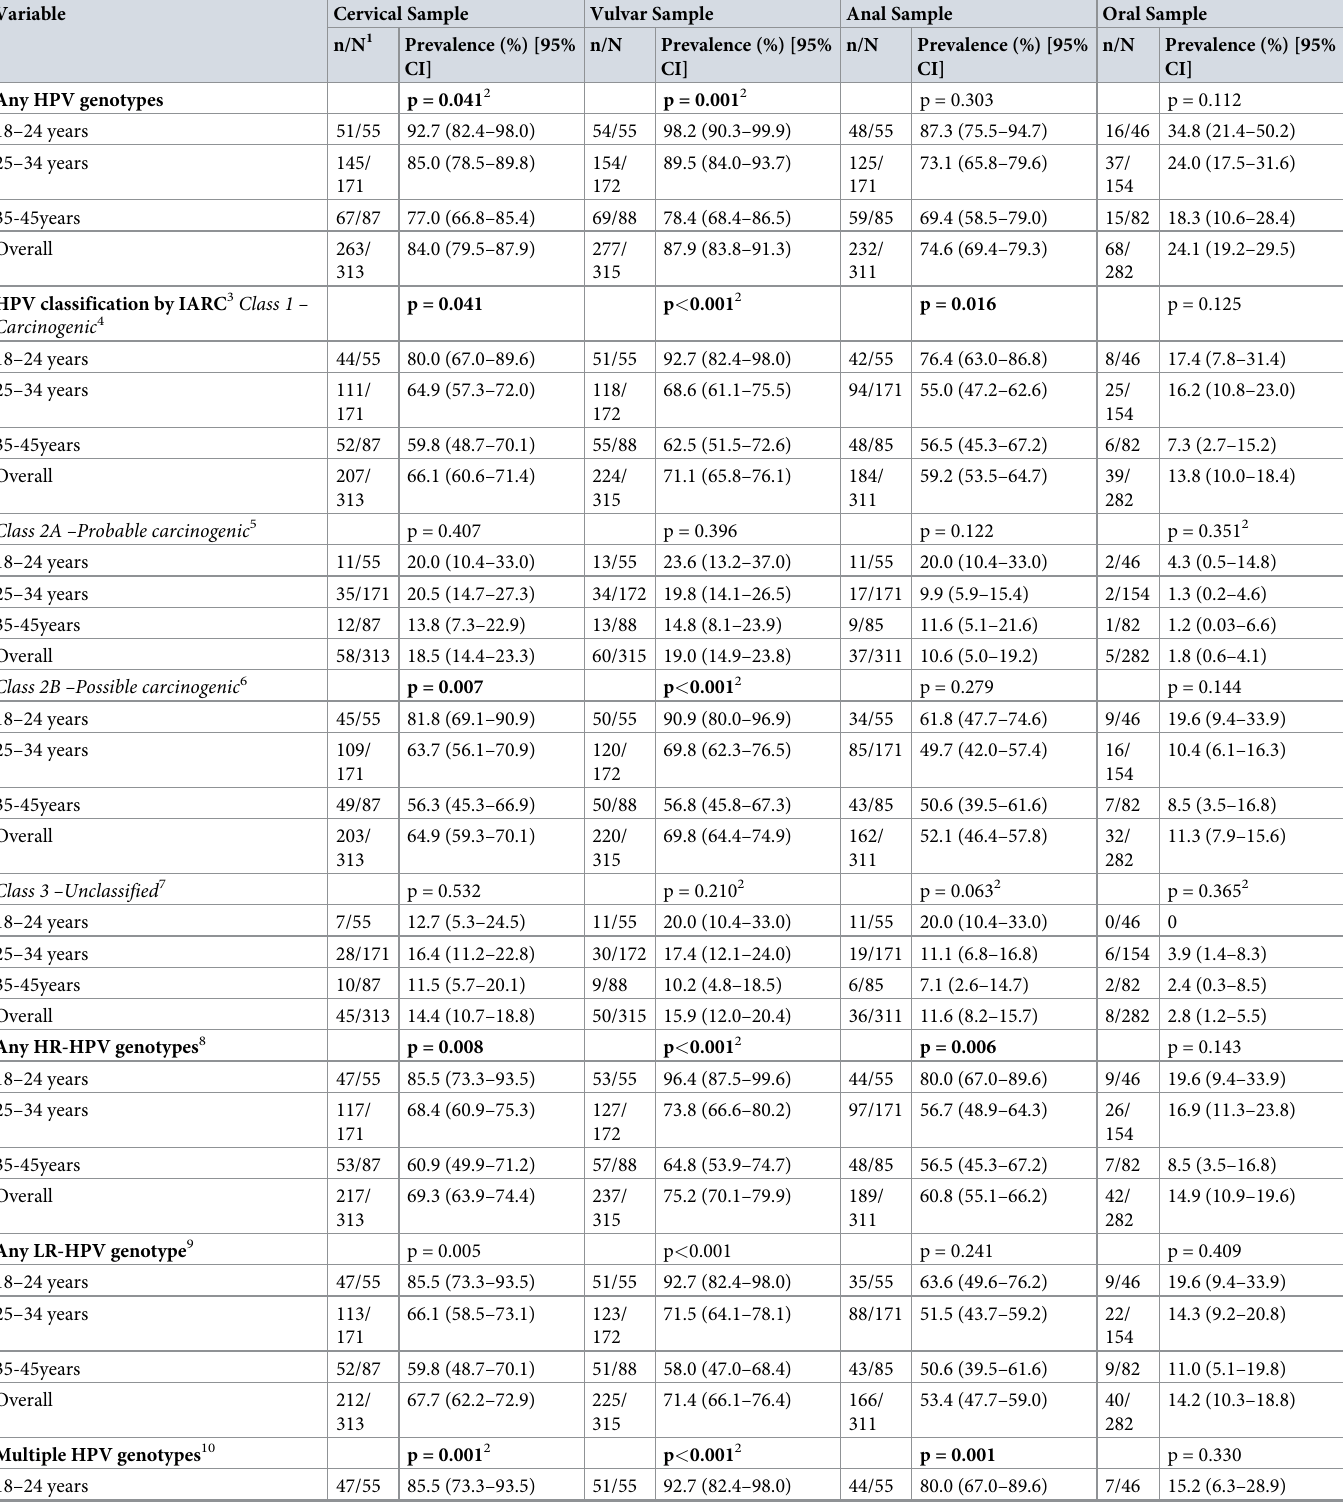
Table 2. Prevalence of Human papillomavirus infections among 315 brothel-based female sex workers in Ibadan,